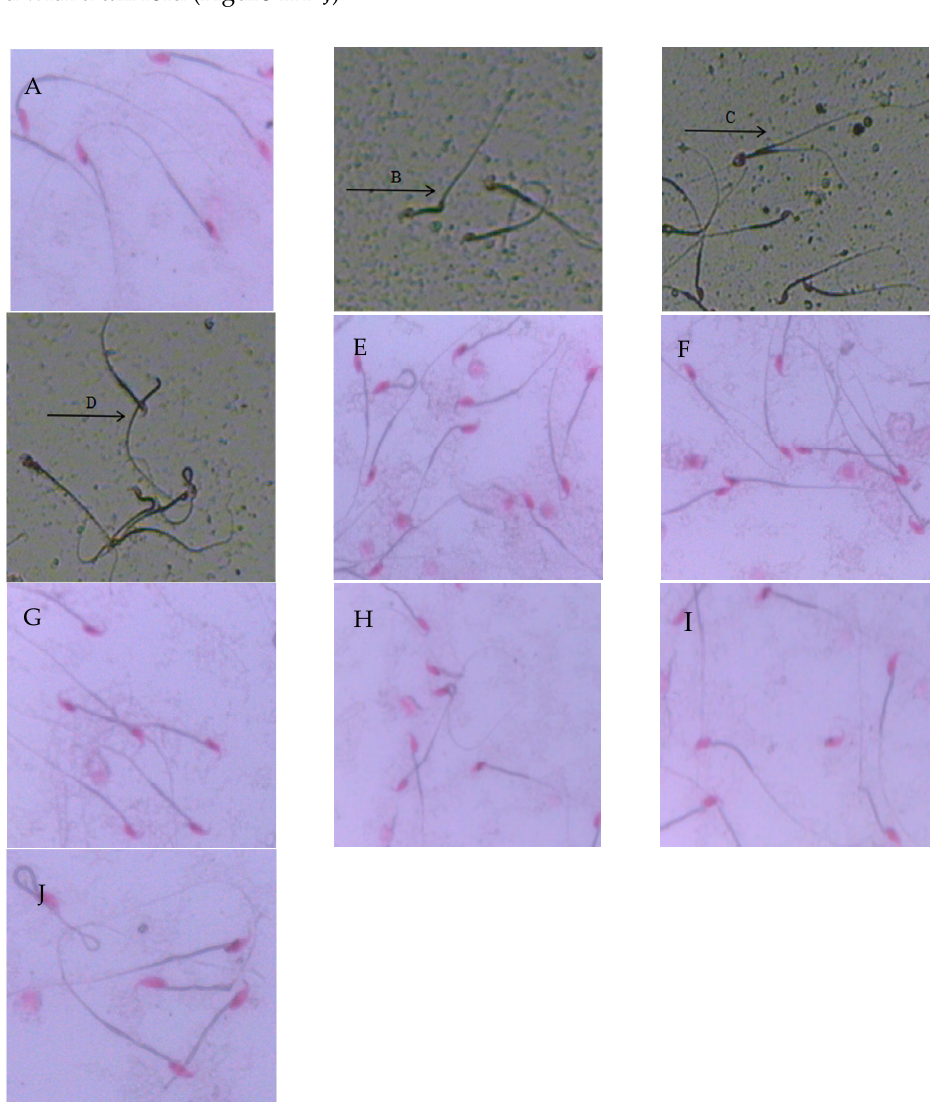
Figure 1. Effect of ZEN, different concentrations of selenium, and their co-treatment on morphology changes in mice sperm in mice testis (original magnification, ×400). ( A ) control group; ( B – D ) ZEN (40 mg/kg) group, ( E ) 0.1 mg/kg Se treatment group; ( F ) 0.2 mg/kg Se treatment group; ( G ) 0.4 mg/kg Se treatment group; ( H ) 0.1 mg/kg Se + ZEN treatment group; ( I ) 0.2 mg/kg Se + ZEN treatment group; ( J ) 0.4 mg/kg Se + ZEN treatment group. Note: B : neck bending; C : two tails; D : no head.